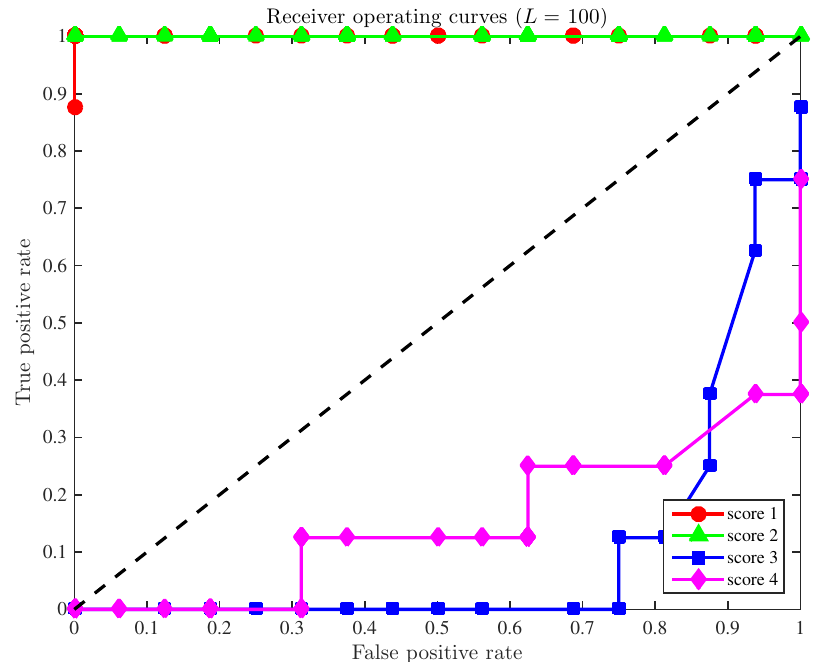
Figure 9. The ROCs for the four scores when the number of time instants per row is L =